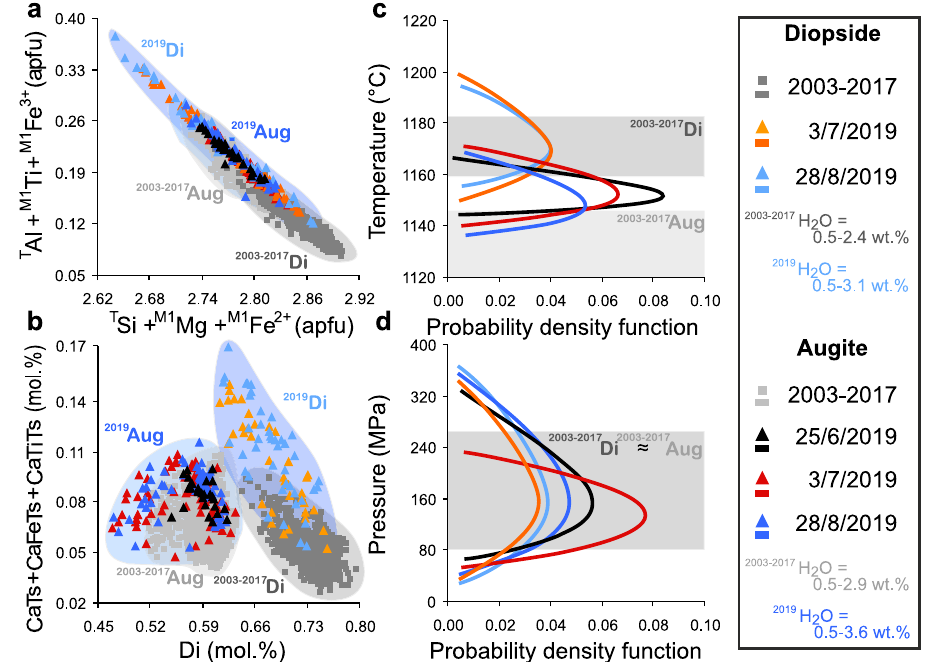
Fig. 4 | Chemical composition of 2019 clinopyroxenes and P-T crystallisation conditions.a Al+Ti+Fe 3+ (apfu)vs.Si+Mg+Fe 2+ (apfu)and( b )CaTs+CaFeTs+CaTiTs (mol.%) vs. Diopside (Di, mol%) diagrams showing the chemical composition and range of variability of augitic and diopsidic portions of the 2019 clinopyroxenes (black triangle: 25 June major explosion; orange and red triangle: 3 July paroxysm; and cyan and blue triangle: 28 August paroxysm) compared with the augitic and diopsidic composition of 2003 – 2017 clinopyroxenes (grey fi eld and square) from DiStefanoetal. 3 .Atthe scaleof the fi gure,errorbarsare smallerthanthesymbols. CaTs+CaFeTs+CaTiTs (mol.%) show the Tschermak-style cation substitution [ T Si, M1 Mg, M1 Fe 2+ ] → [ T Al, M1 Ti, M1 Fe 3+ ]. Probability density function of temperature ( c )andpressure( d )for2019augite(blackline:25June,basedon28datapoints;red line: 3 July, 82 datapoints; and blue line: 28 august, 56 datapoints) and diopside (orange line: 3 July, 37 datapoints; cyan: 28 August, 44 datapoints) compositions compared with the P-T range of 2003-2007 eruptive period (grey band) from